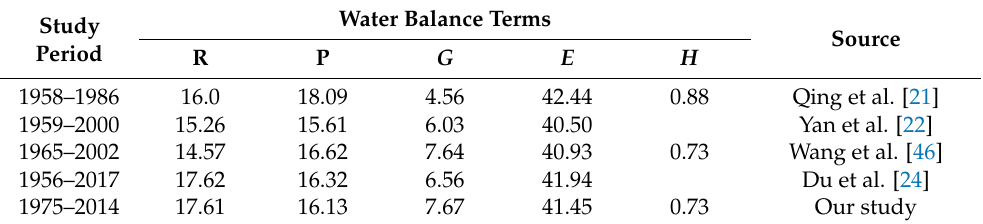
Table 10. Previous studies of water composition from Lake Qinghai. (Unit: 10 8 m 3 /a). Study